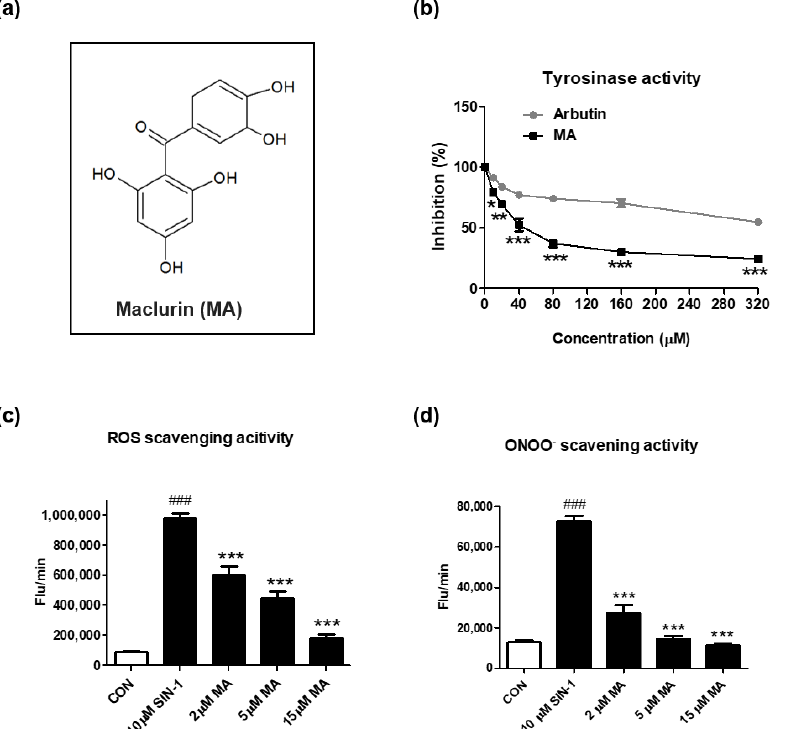
Figure 1. Inhibitory effects of maclurin on tyrosinase and oxidative stress in cell-free systems. ( a ) The chemical structure of maclurin. ( b ) The inhibitory effects of maclurin and arbutin on tyrosinase were measured in the cell-free system using L-tyrosine as the subtract and tyrosinase as the enzyme. To examine the inhibitory effect of maclurin on oxidative stress, reactive oxygen species (ROS) and peroxynitrite (ONOO − ) were generated by 3-morpholinosydnonimine (SIN-1). ( c ) ROS and ( d ) ONOO − were analyzed by DCFDA and DHR123 as fluorescent probes in a cell-free system after 30 min incubation. Results represented the mean value ± SEM at least three times. The data were compared by ANOVA, followed by Dunnett’s multiple comparison test. ### p < 0.001 compared with the non-treated control group and * p < 0.05, ** p < 0.01, *** p < 0.001 compared to the SIN-1-treated group or the arbutin-treated